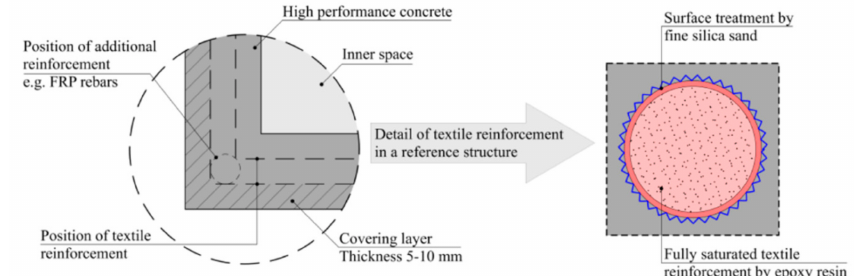
Figure 1. Composition of a TRC structural column.